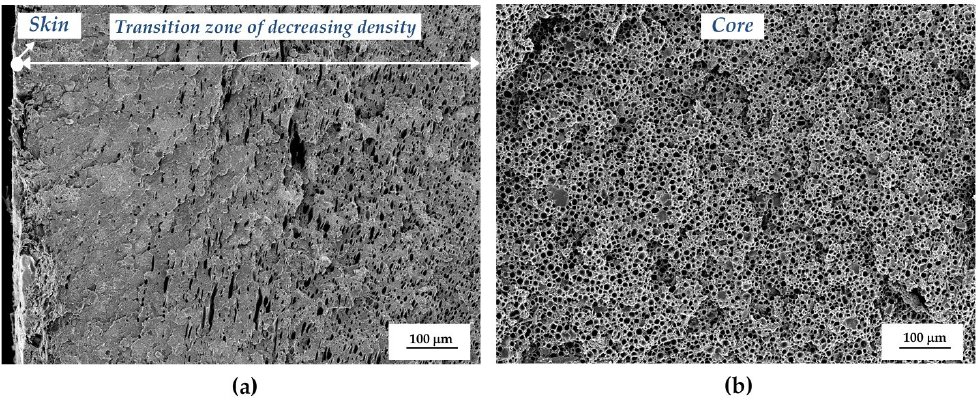
Figure 2. Low magnification SEM images showing the characteristic structure of injection-molded foams (ABS/PFR-15): ( a ) Skin and transition zone; ( b ) Core zone.